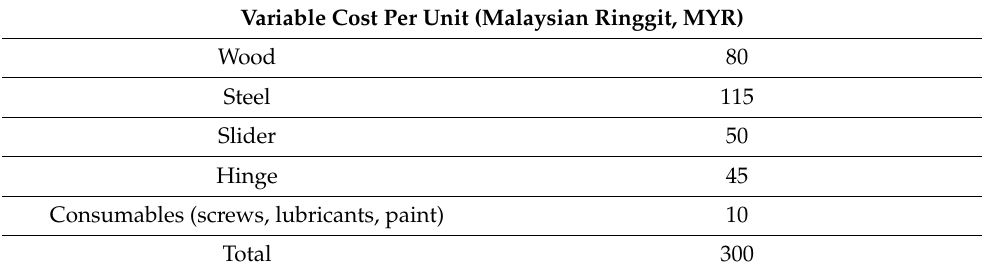
Table 17. Material cost per unit (case 1).